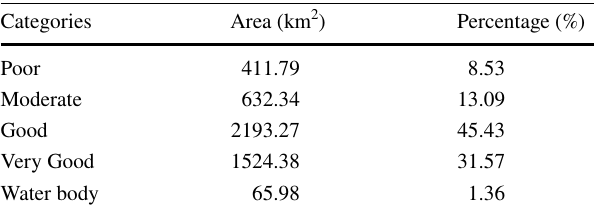
Table 7 Groundwater potential zones category and their distribution